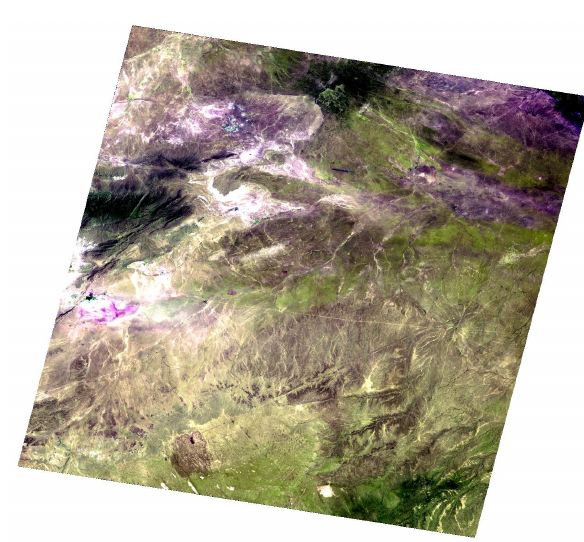
Figure 4. Map of the Syrian Desert Caravan Routes by C. P. Grant. Early 20 th century.